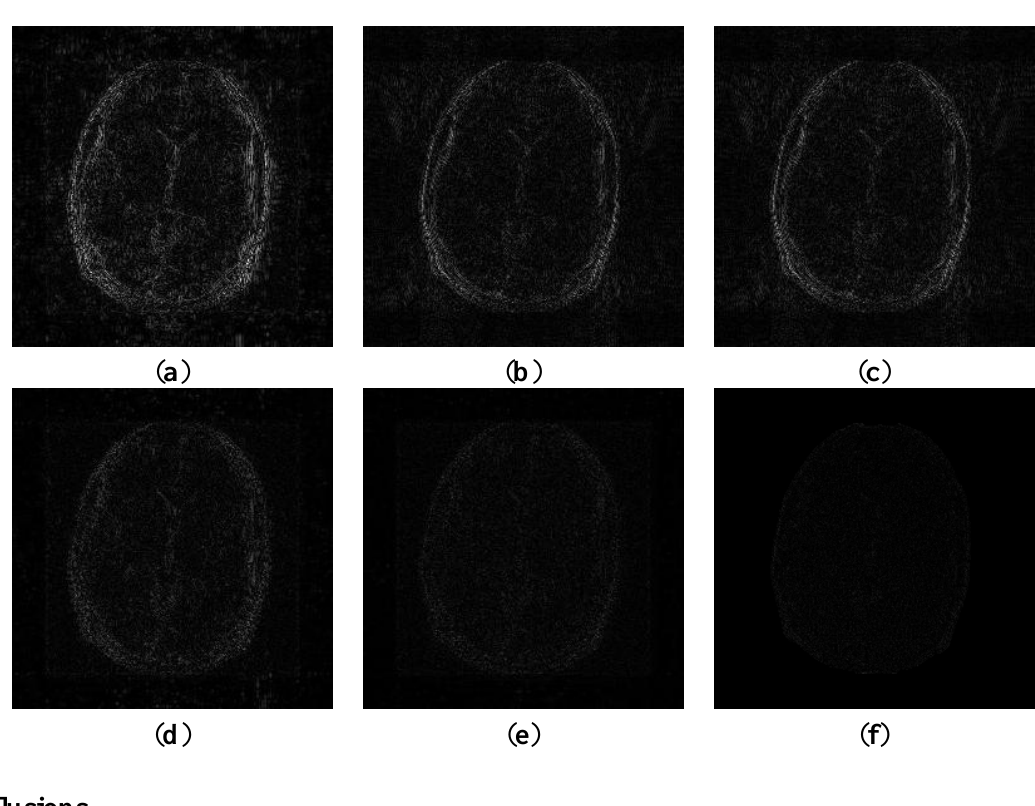
Figure 10. Difference Images. ( a ) DCS; ( b ) CS SENSE; ( c ) SAKE; ( d )